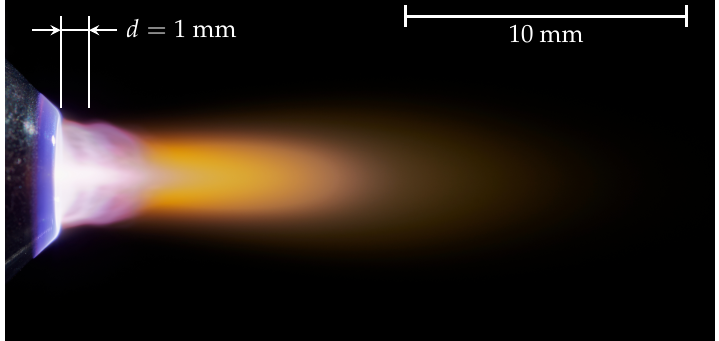
Figure 5. The effluent plasma jet of a PG31 generator equipped with an A450 nozzle, showing the axial distance d = 1 mm at which the measurements were performed.